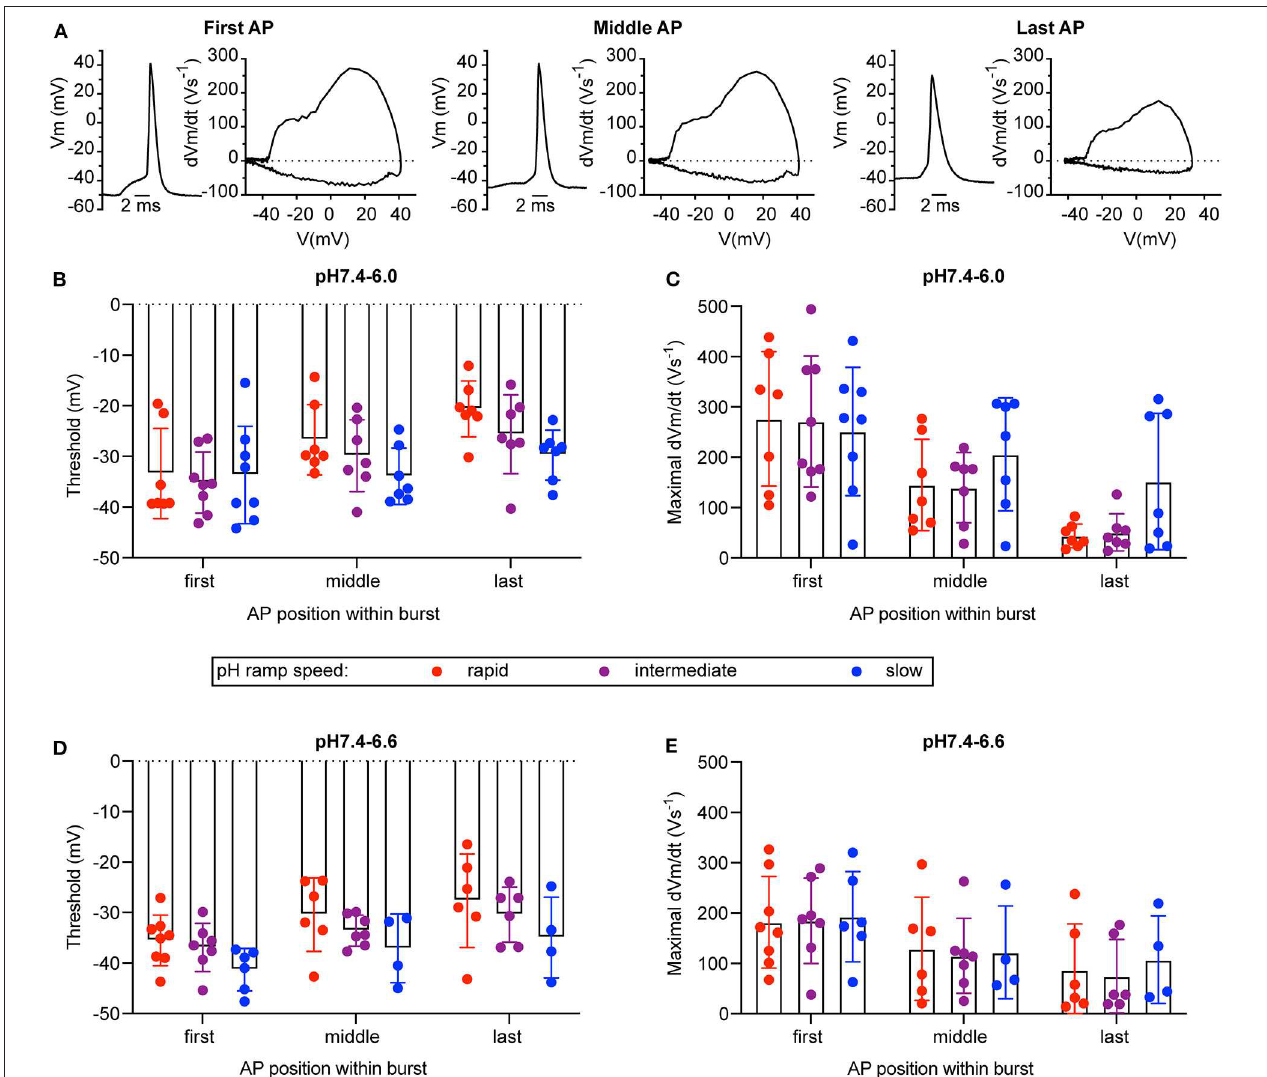
FIGURE 8 | Phase-plane analysis of neuronal action potentials. The data are from current-clamp experiments with WT cultured cortical neurons; baseline current was injected to obtain a resting membrane potential close to − 60mV. The pH ramp protocols produced in control experiments a fall time of 2.0 ± 0.1s (rapid), 4.4 ± 1.8s (intermediate), and 17.8 ± 6.7s (slow; n = 3, mean ± SEM), respectively. Of each induced AP burst, the properties of the first, the last, and of an AP in the center of the burst was submitted to the phase-plane analysis. Red, purple, and blue data points were obtained from rapid, intermediate and slow pH ramps, respectively. (A) Representative APs and corresponding phase-plane plots of an AP burst induced by a pH 7.4–6.6 ramp of intermediate speed. (B,D) Threshold of AP generation in response to pH 7.4–6.0 (B) or pH 7.4–6.6 ramps (D) , n = 4–8. (C,E) Maximal AP upstroke velocity measured in experiments with AP induction by pH 7.4–6.0 (C)